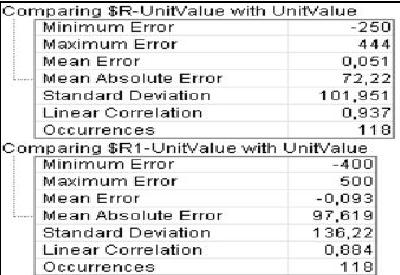
Fig. 12. The performance analysis of C&RT and CHAID algorithms (developed by the authors).